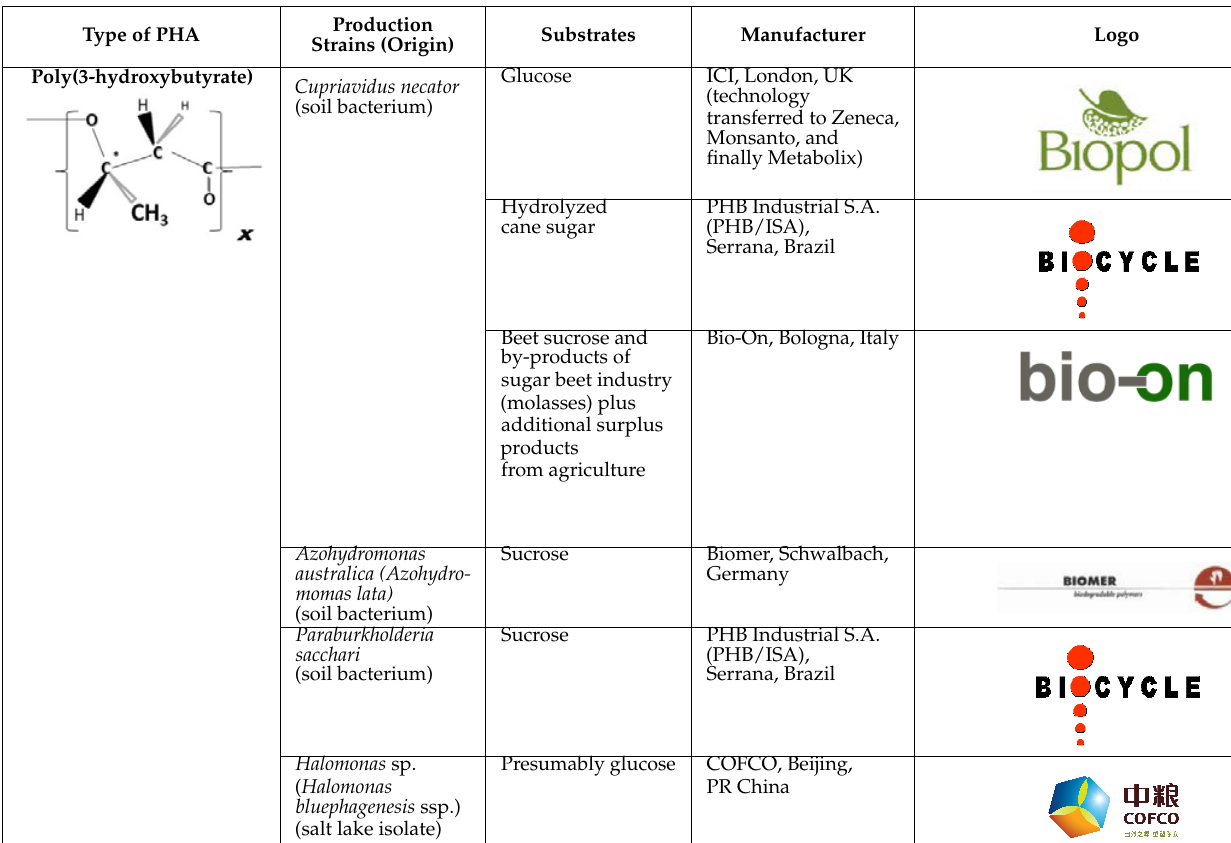
Table 1. Most commercialized types of PHA (P(3HB), P(3HB- co -3HV), P(3HB- co -4HB), P(3HB- co -3HHx), P(4HB)), production strains, substrates, manufacturers, manufacturing scale/capacity, and certifications.